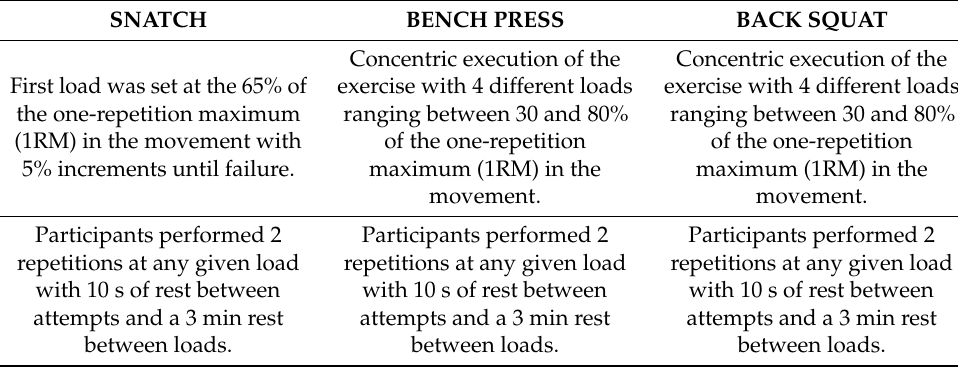
Table 2. Protocols followed in the incremental